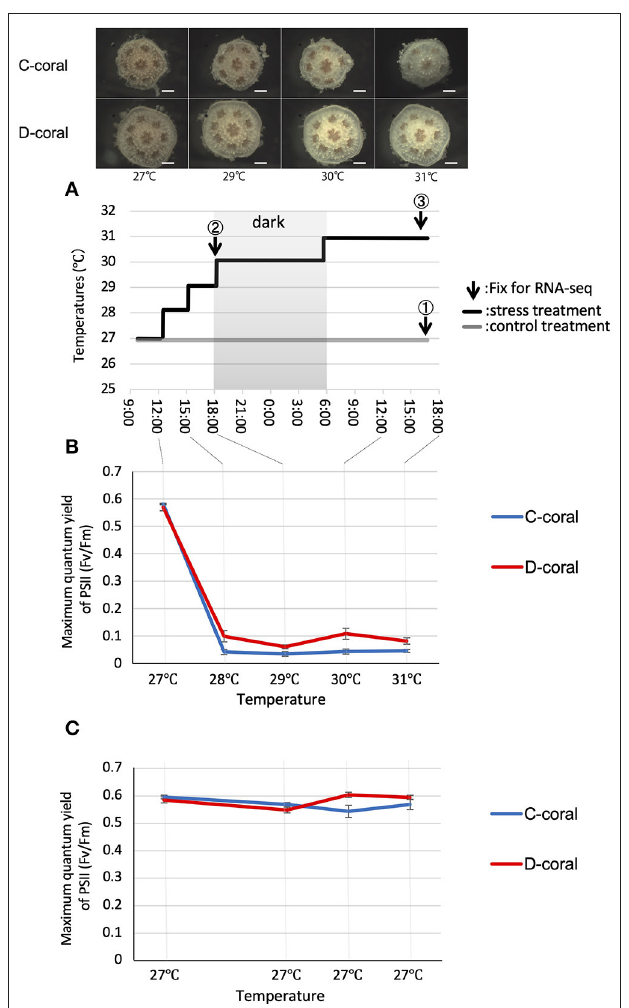
FIGURE 1 | (A) Experimental design for stress experiments and stereoscopic microscope images of Acropora solitaryensis during temperature increase from 27 to 31 ◦ C. The upper pictures show A . solitaryensis colonized by C-type algae (C-coral); lower pictures show A . solitaryensis colonized by D-type algae (D-coral). The graph shows the transition of the temperature setting during the experiment. Arrows indicate the time of fixation for RNA-seq analysis. The samples derived from each time point are referred to as day 1 (at 29 ◦ C, collected before setting 30 ◦ C), day 2 (at 31 ◦ C), and control. For RNA-seq analysis, we prepared two replicates (each replicate with 15 pooled colonies) for each treatment (stress conditions and control conditions) ( Supplementary Figure S2 ). Scale bars = 0.5mm. (B,C) Maximum quantum yield ( Fv/Fm ) of C-type ( Cladocopium ) and D-type ( Durusdinium ) Symbiodiniaceae associated with corals in stress (B) and control treatments (C) . No significant difference was found between C-type and D-type in same treatment; however, there were significant differences between control and stress treatments in both C-type and D-type (Turkey–Kramer HSD, p < 0.05). Values are means ±